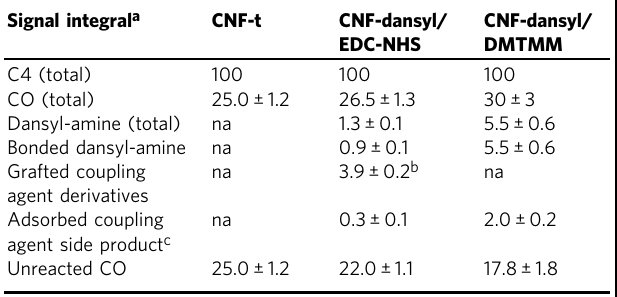
Table 1 Estimation of the relative amount of the different species present at the surface of CNF-t, CNF-dansyl/EDC- NHS, and CNF-dansyl/DMTMM with respect to the number of cellulose